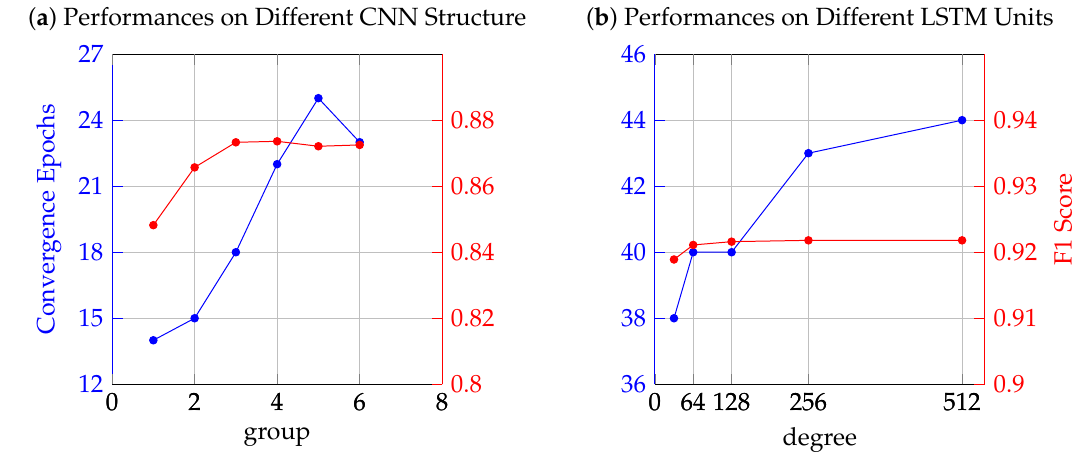
Figure 5. Hyperparameter selection